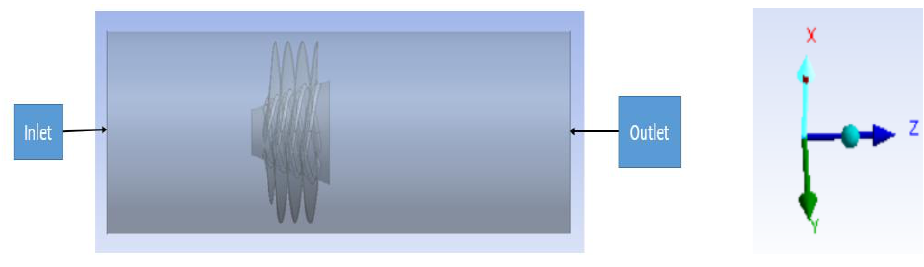
Figure 2. Simplified schematic diagram of the induction rotation domain, inlet and outlet.